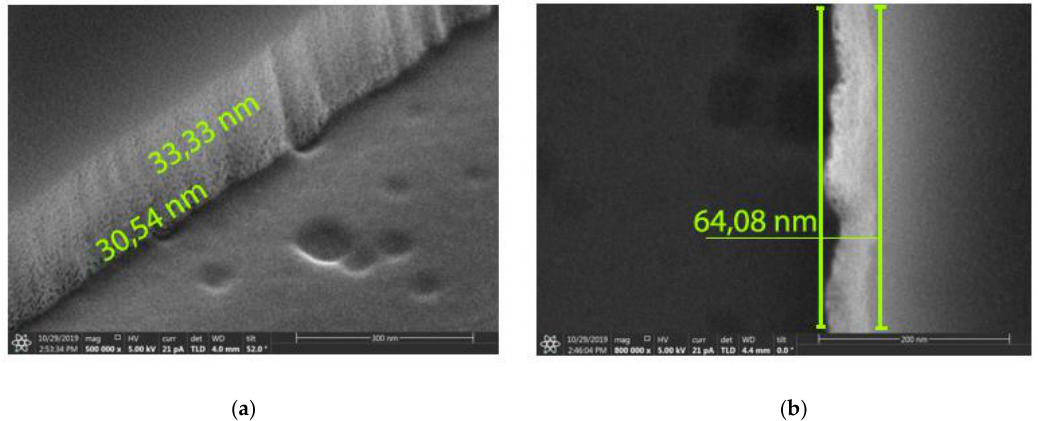
Figure 2. SEM image of the side surface of the silicon nitride profile after plasma-chemical etching: side view ( a ); view from above ( b ).